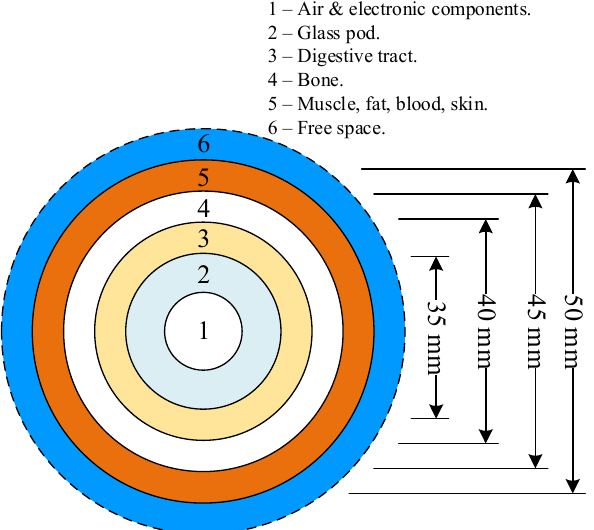
Figure 7. The lossy multilayer spherical body-parts model with varying dielectric constants. Table 3. The conductivities and dielectric constants of human organs and body parts [28]. Body Parts